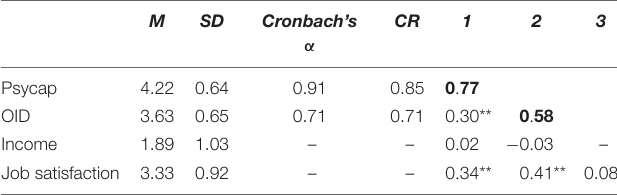
TABLE 2 | Descriptive statistics and correlations between study